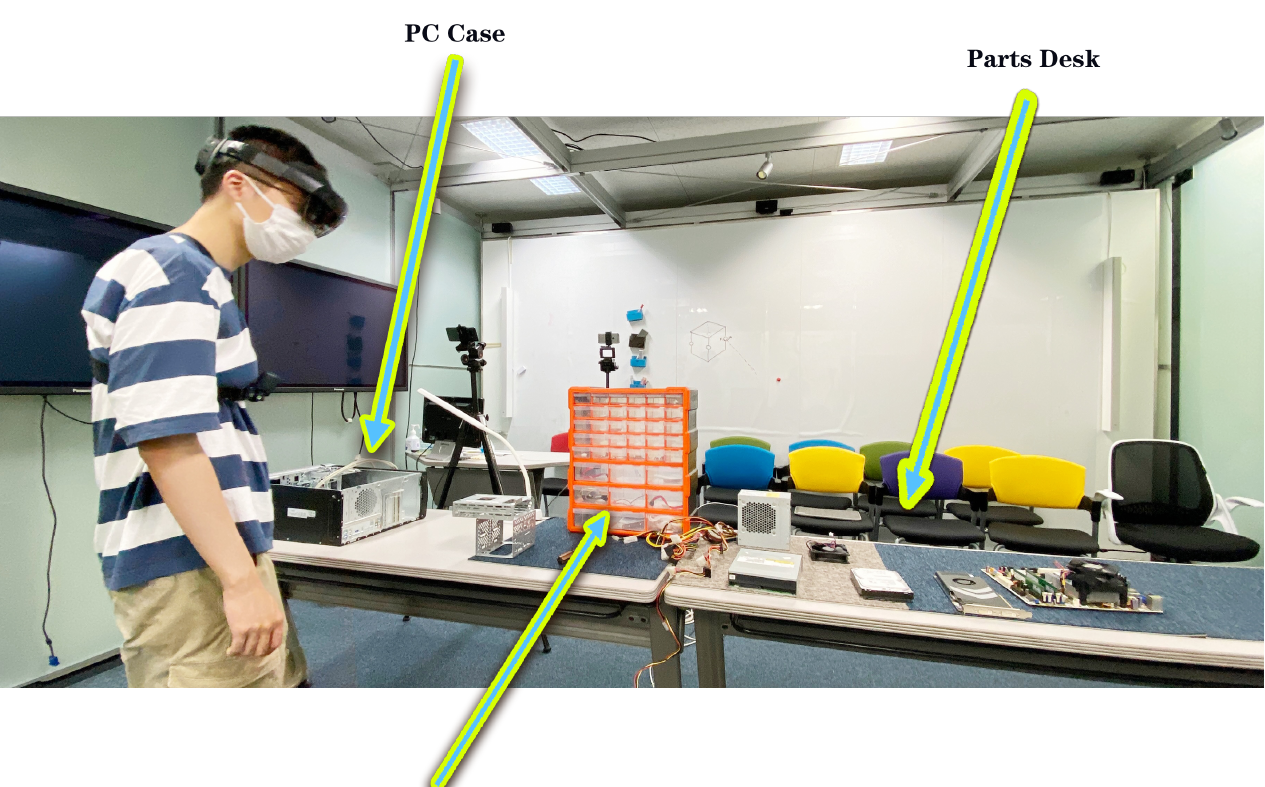
Figure 31. Experimental scene setting of PC assembly